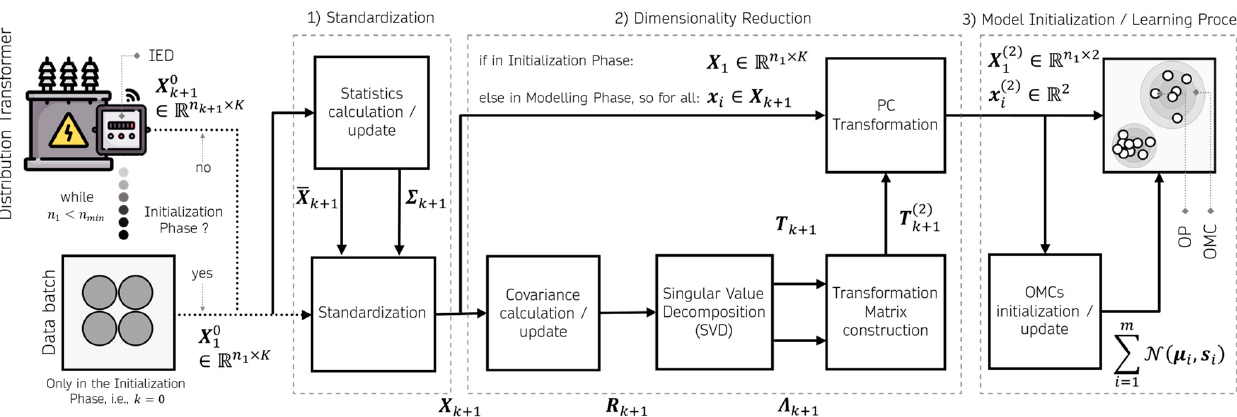
Figure 2. Flowchart of the initialization and modeling phases of the real ‐ time automatic diagnostic method.